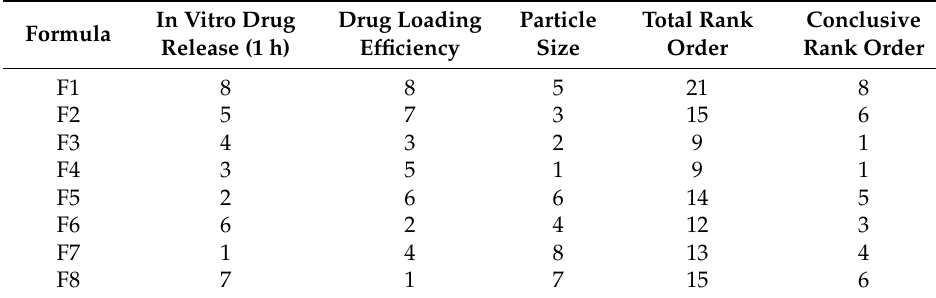
Table 9. Rank Order of OLM SNEDDS Formulae According to In Vitro Drug Release Data, Drug Loading Efficiency and Particle Size Analysis.